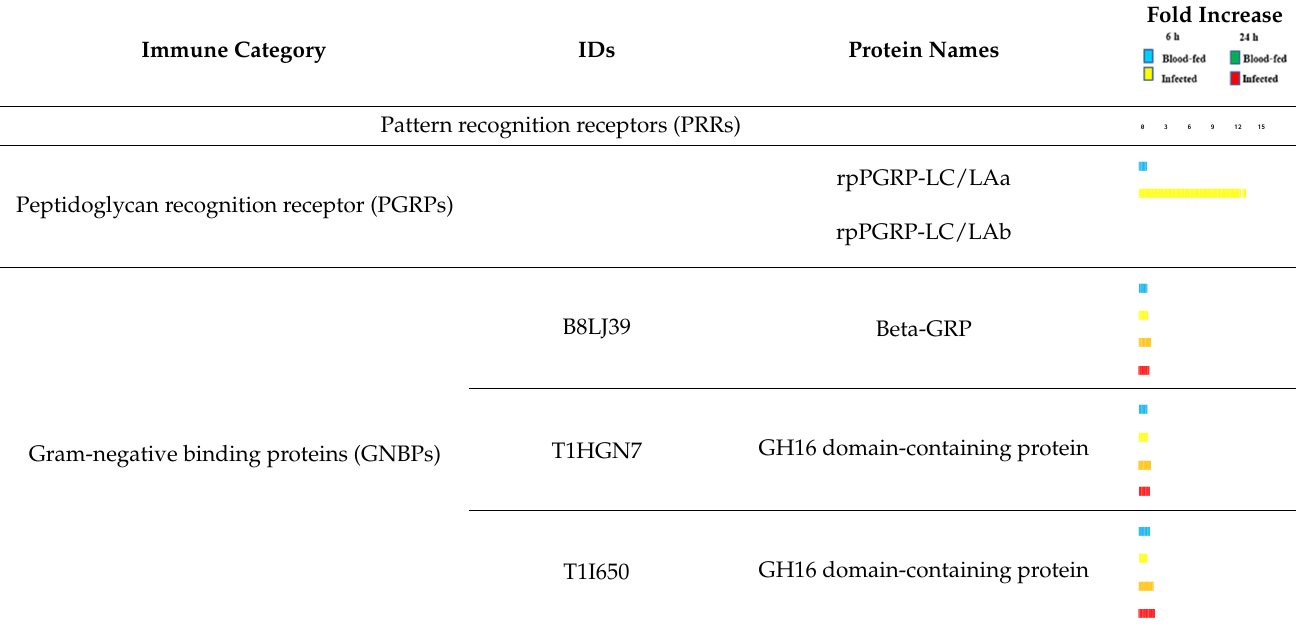
Table 1. Expression pattern of immunity related proteins identified in R. prolixus hemolymph.